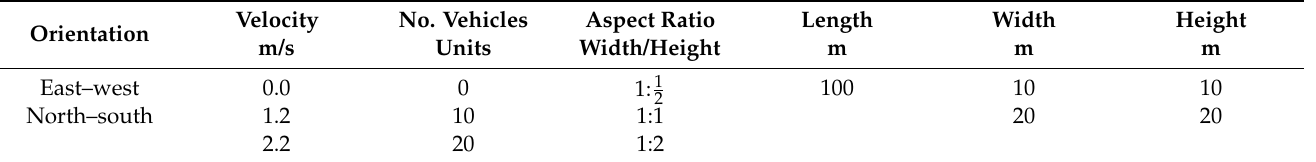
Table 1. Simulation variables and its values.